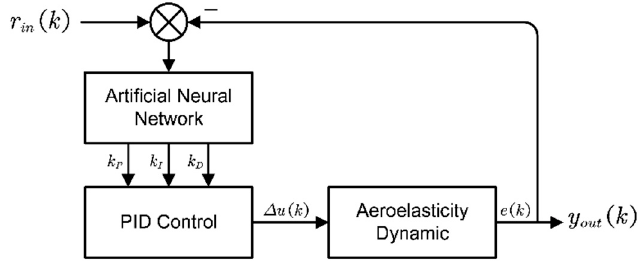
Figure 10. Fuzzy neural network PID control system structure.